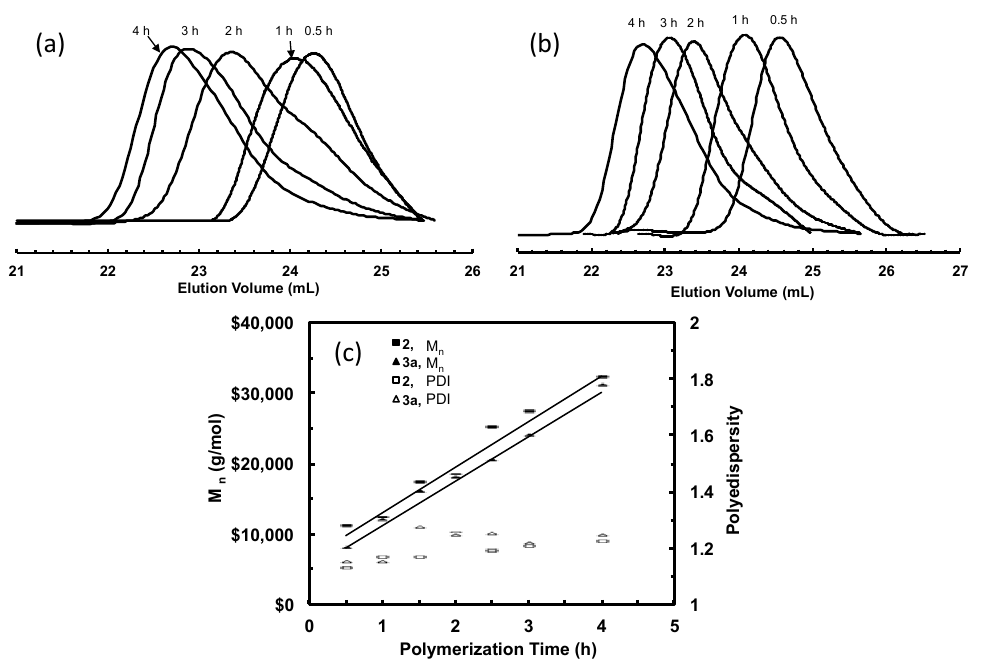
Figure 11. GPC elution curves of poly(1-hexene)s produced at different polymerization time using: ( a ) 2 ; and ( b ) 3a , at 0 °C and [1-hexene] = 1.15 M. ( c ) Plot of M n and PDI for poly(1-hexene)s produced with 2 and 3a as functions of polymerization time.